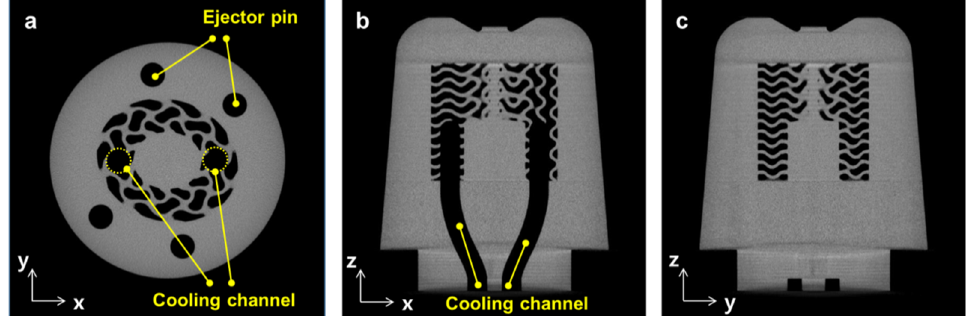
Figure 14. Additively manufactured metal mold containing the TPMS structure: ( a ) Sectional con- figuration of the upper core. ( b ) Additively manufactured upper core (sliced sample for verification of inner TPMS structure). ( c ) Experimental setup for the injection molding experiment.